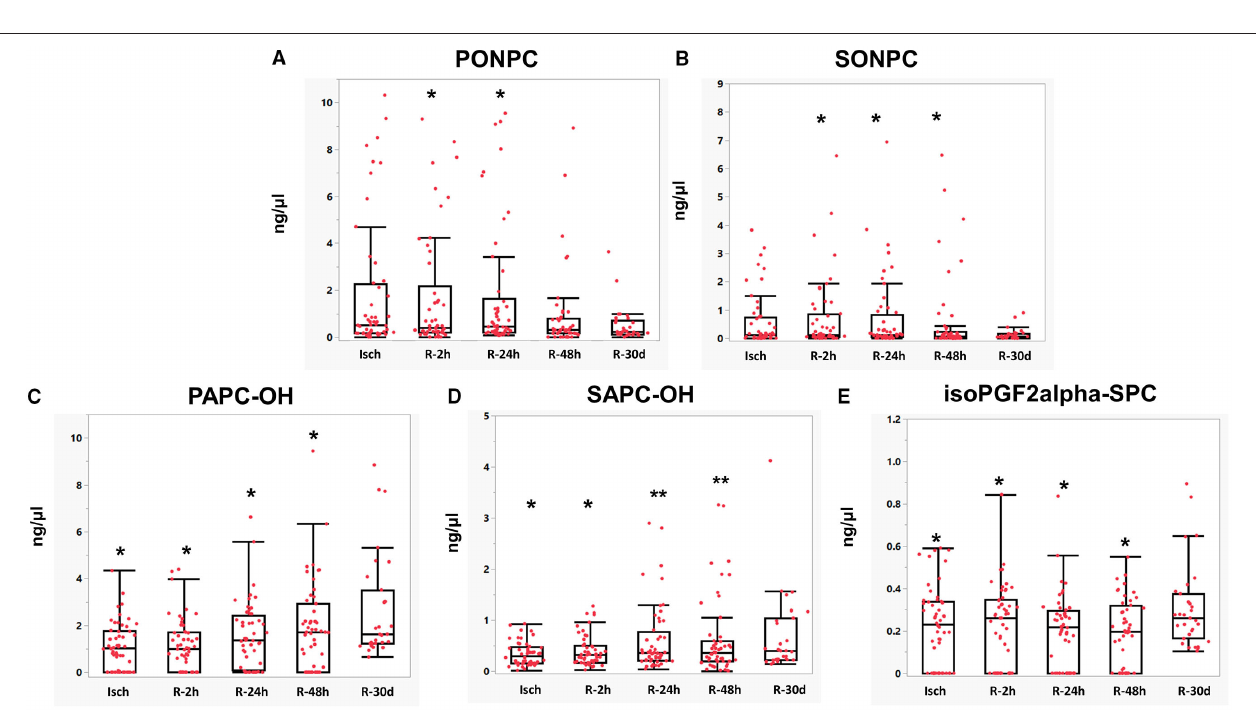
FIGURE 6 | (A–E) Mean comparisons of OxPC species in STEMI patient during I/R. *Significantly different compared with R-30 d, P < 0.05. **Significantly different compared with the Isch group.